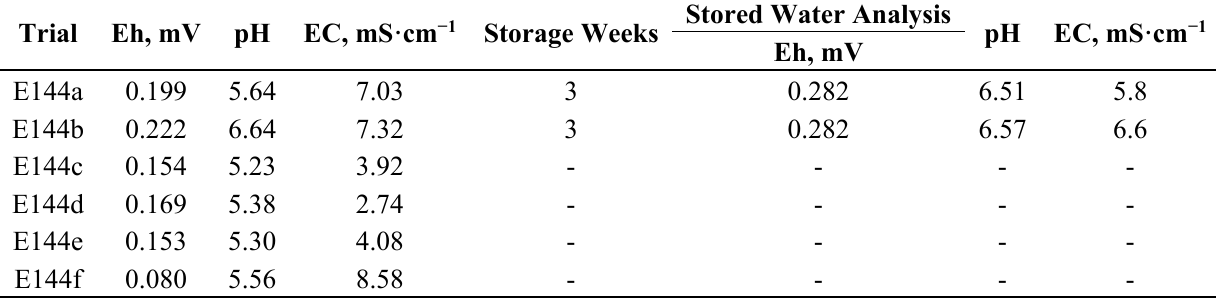
Table C10. ZVM TPA Example (Trial E144): Product Water Composition.